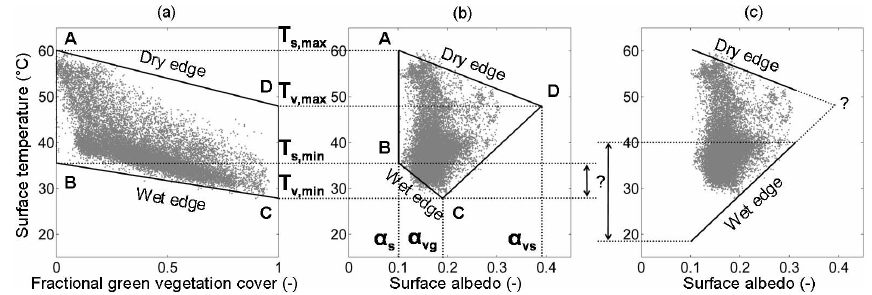
Fig. 1. Consistent interpretation of the edges and vertices of the T − f vg and T − α polygons ( a and b ), as compared with the classical interpretation of the T − α space (c) . Underlying grey points correspond to data on 27 April